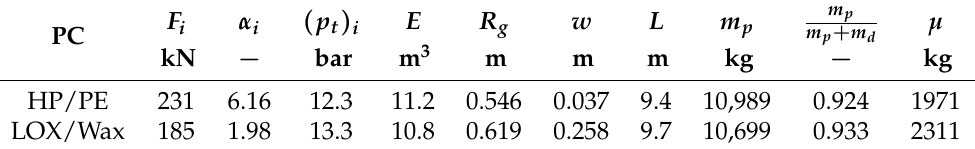
Figure 5. Deterministic optimization (800 km altitude): thrust ( F ), longitudinal acceleration ( F / m ), specific impulse ( I SP ) and mixture ratio ( α ) histories of deterministic optimal design A (left sub- figures) and B (right sub-figures). Table 12. Hybrid upper stage design and performance. The first column reports the propellant combination. E column reports the initial nozzle area ratio when erosion effects are